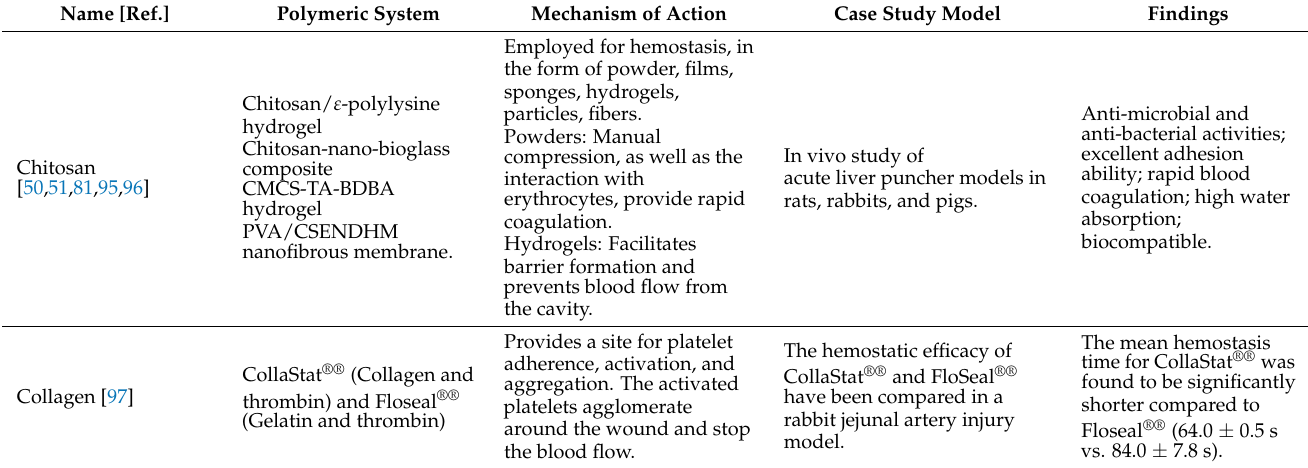
Table 1. Hemostatic functions of natural polymeric